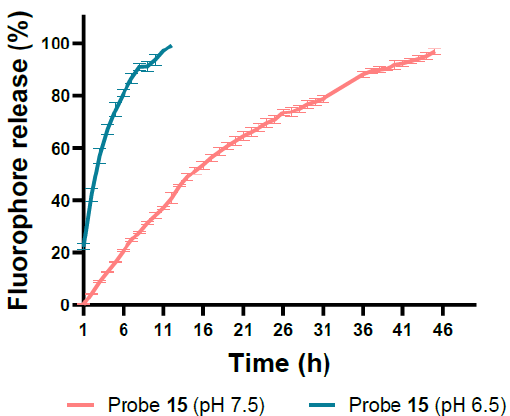
Figure 3. The correlation of the free fluorophore release with respect to time for probe 15 when incubated in PB/EtOH (1:1 v/v, pH = 7.5) and PB/EtOH (1:1 v/v, pH = 6.5). All the experiments were at 37 °C and 25 µM concentrations. Values were recorded in triplicate. Error bars are S.E.M.